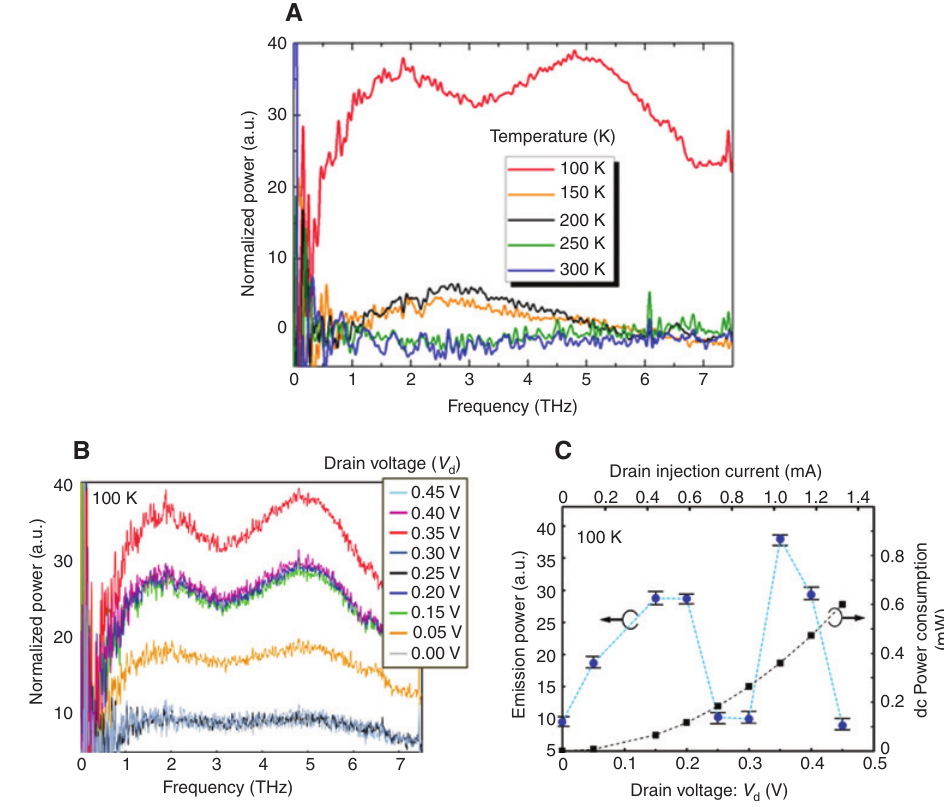
Figure 6: The threshold temperature for amplified spontaneous broadband THz emission stays between 100 and 150 K. The device also exhibits double-threshold-like behavior with respect to V